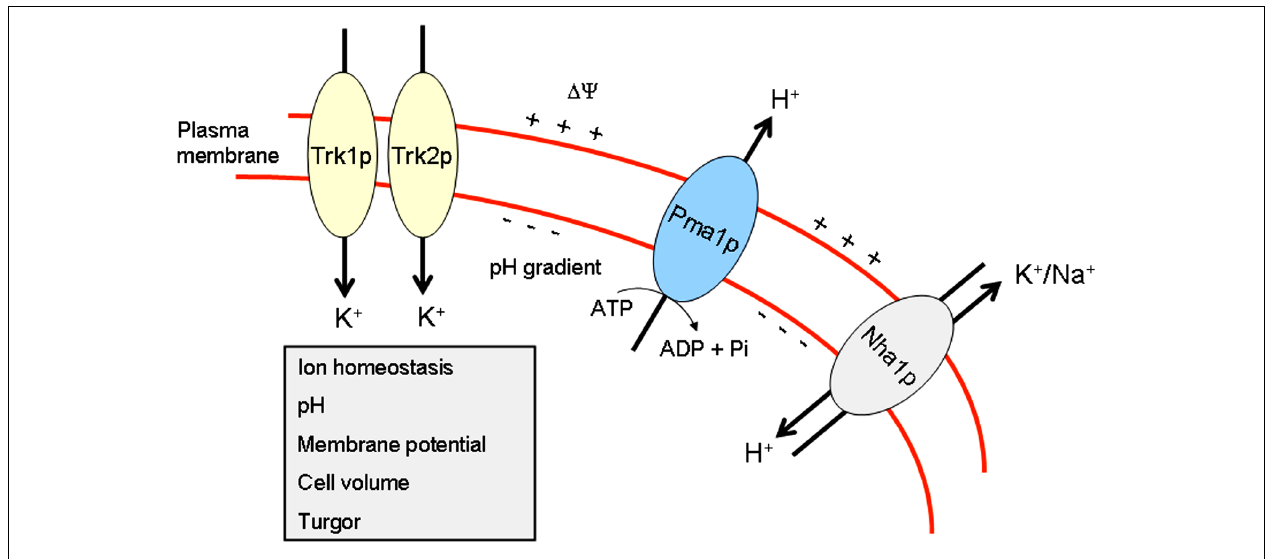
FIGURE 1 | Ion homeostasis in yeast. This scheme portrays the major proteins, Pma1p,Trk1p,Trk2p, and Nha1p, involved in maintaining ion homeostasis in S. cerevisiae .